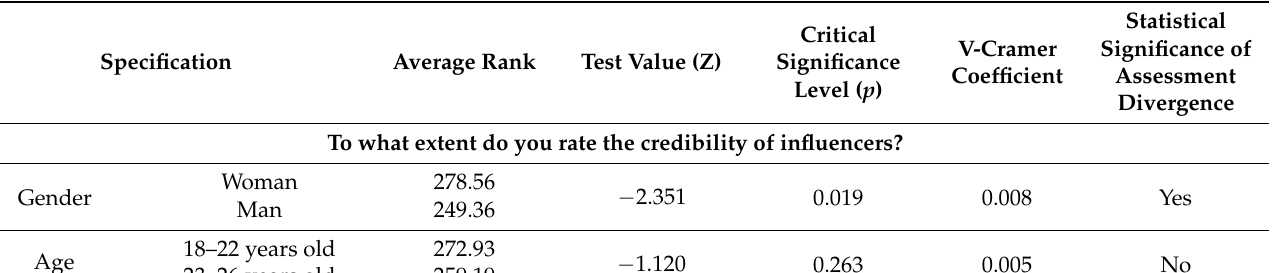
Table 6. An assessment of the relationship between the assessment of the impact of influencers on social media on consumer behavior and the variables describing